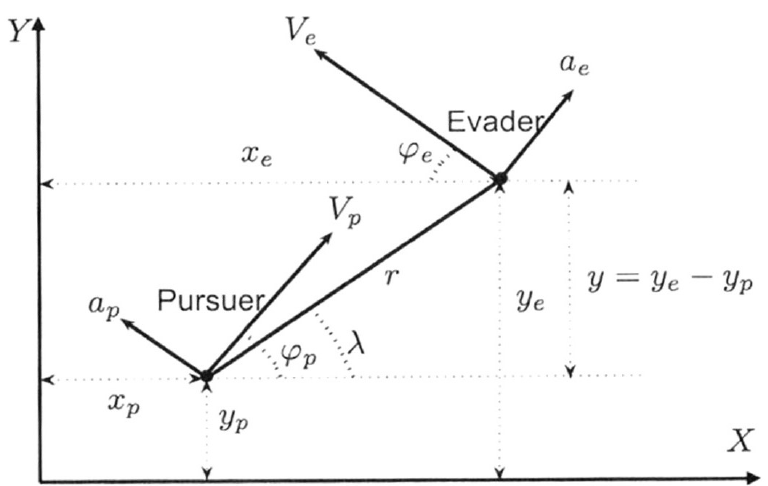
Figure 1. Geometry of the interception